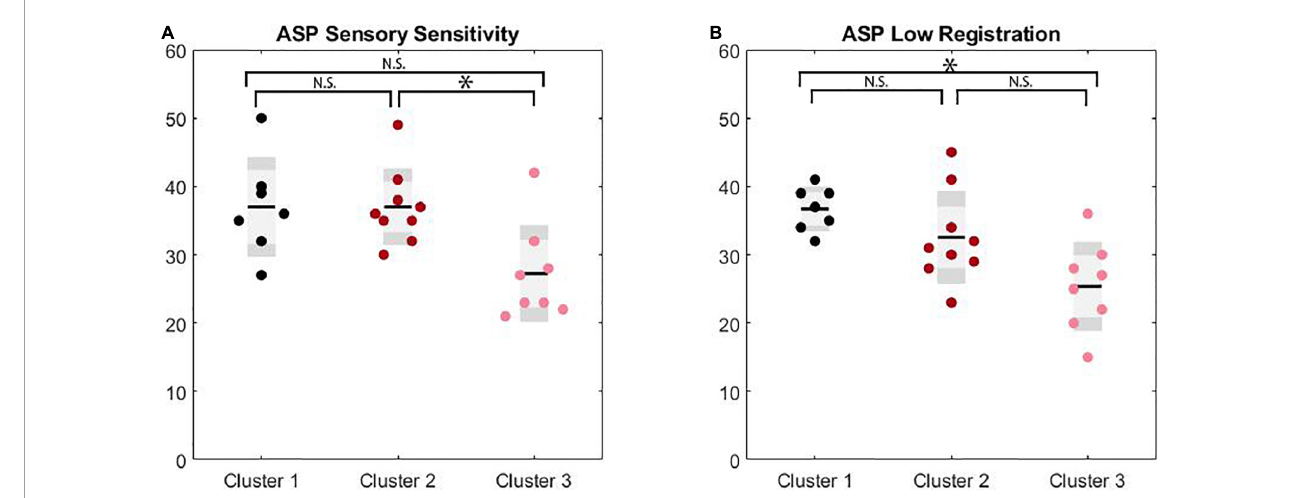
FIGURE3 Significance markers reflect non-corrected MANCOVA results. N.S. = not significant, ∗ p < 0.05. (A) Box plots depicting group comparison across clusters for ASP sensory sensitivity with overall significance ( p = 0.02) where cluster 2 showed significantly higher sensitivity scores than cluster 3 ( p = 0.02). (B) Box plots depicting group comparison across clusters for ASP low registration with overall significance ( p = 0.03) where cluster 1 showed a trend toward significantly higher low registration scores than cluster 3 ( p =